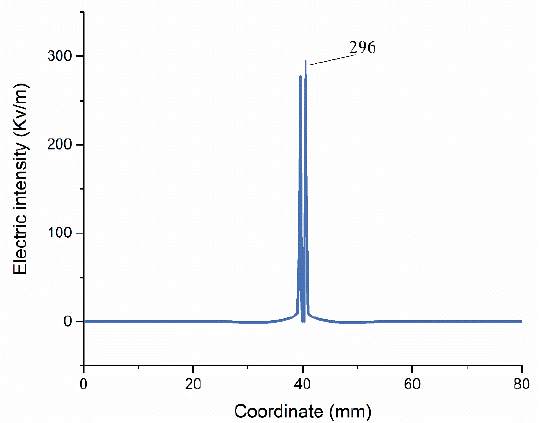
Figure 7. Single-antenna electric field ( E rms ) distribution diagram.